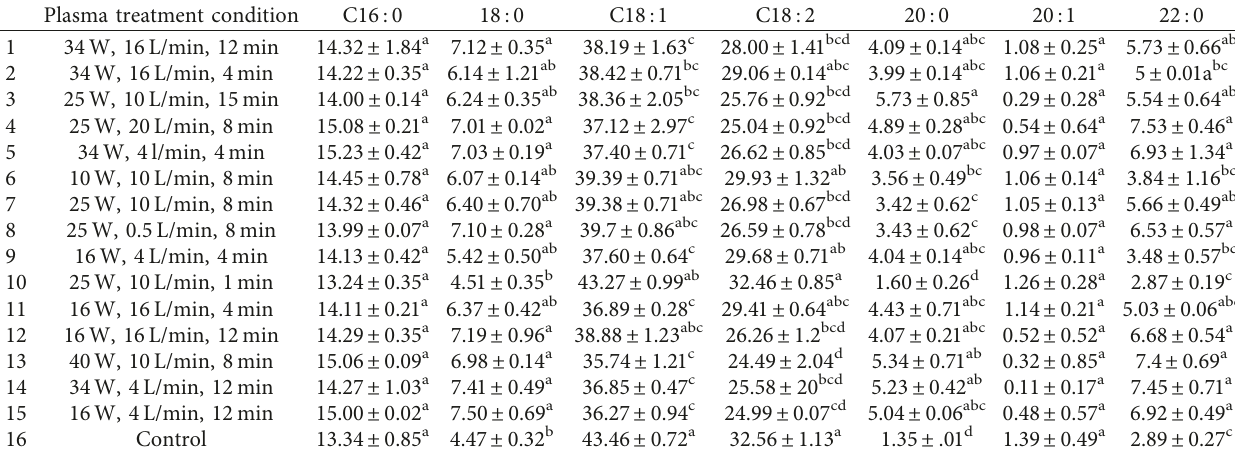
Table 1: Mean values comparison of fatty acid profiles of the cold plasma-treated peanut ( p < 0 . 05). Plasma treatment condition